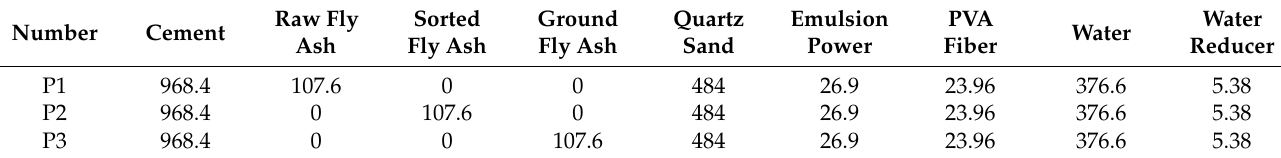
Table 2. Proportional design of